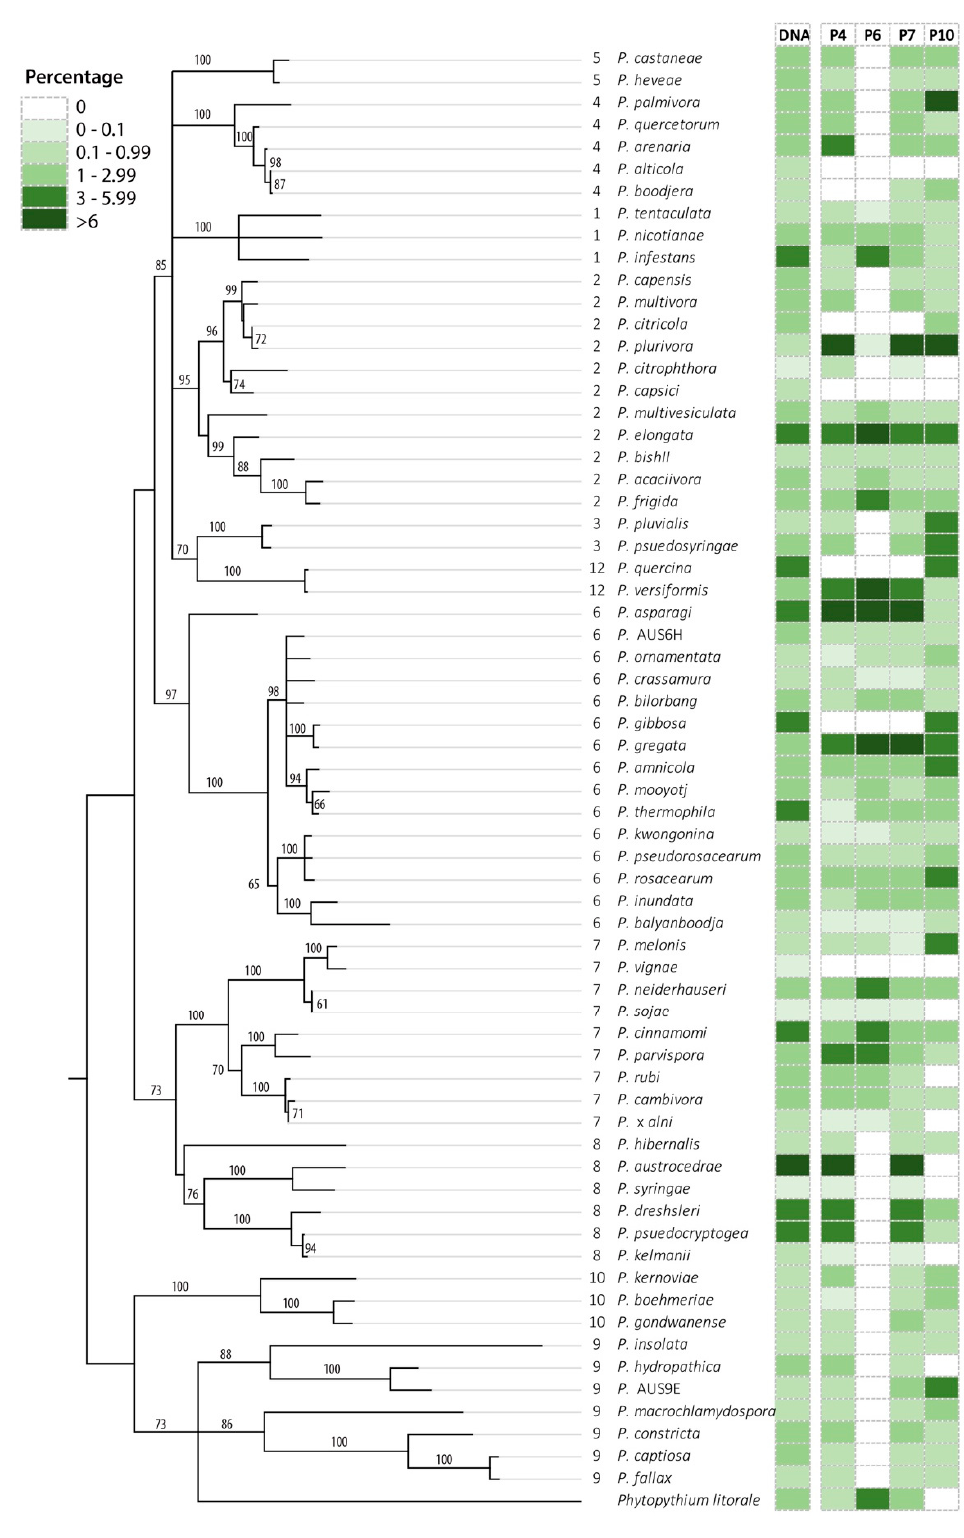
Figure 2. Phylogenetic representation based on ITS gene region of the Phytophthora species in the mock community MIX2. The relative proportion of DNA of each species (as a percentage) and the average relative abundance of reads obtained for each species (as a percentage) are colour-coded as per the legend.